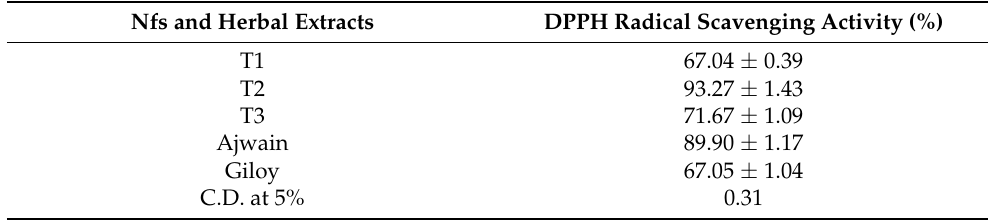
Table 2. Antioxidant activity of different herbal extracts and NFs.